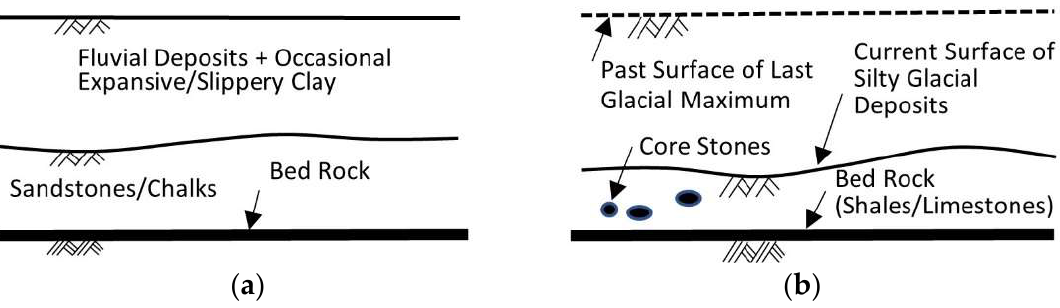
Figure 4. Schematic Layer Profiles in Nebraska (Note: Figures are not in scale). ( a ) Typical soil profile in North, West and Mid-Nebraska. ( b )Typical soil profile in East Nebraska.